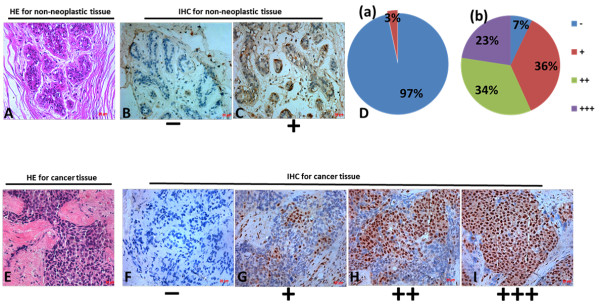
Immunohistochemistry (IHC) analysis of JMJD2A expression in non-neoplastic and breast cancer tissues. (A) Hematoxylin-eosin (HE) staining of non-neoplastic tissues. (B, C) Representative results of the negative staining (B) and weakly positive staining (C) of JMJD2A protein in non-neoplastic tissues. (D) Distributions of JMJD2A staining grades (−, +, ++ and +++) in both non-neoplastic tissues (D, a) and breast cancer tissues (D, b). In non-neoplastic tissues, 29 out of 30 tissues exhibited to be JMJD2A negative and only 1 in 30 tissues exhibited to be JMJD2A weakly positive. In breast cancer tissues, the positive rate of JMJD2A staining in breast cancer tissues (93%) was significantly higher than that in non-neoplastic tissues (3%) (P <0.001). (E) Validation of breast cancer tissues by HE stain. (F, G, H, I) Representative results of negative staining (−, F), weakly positive staining (+, G), moderate staining (++, H) and strong staining (+++. I) of JMJD2A protein in breast cancer tissues are shown respectively. Scale bar = 20 μm.